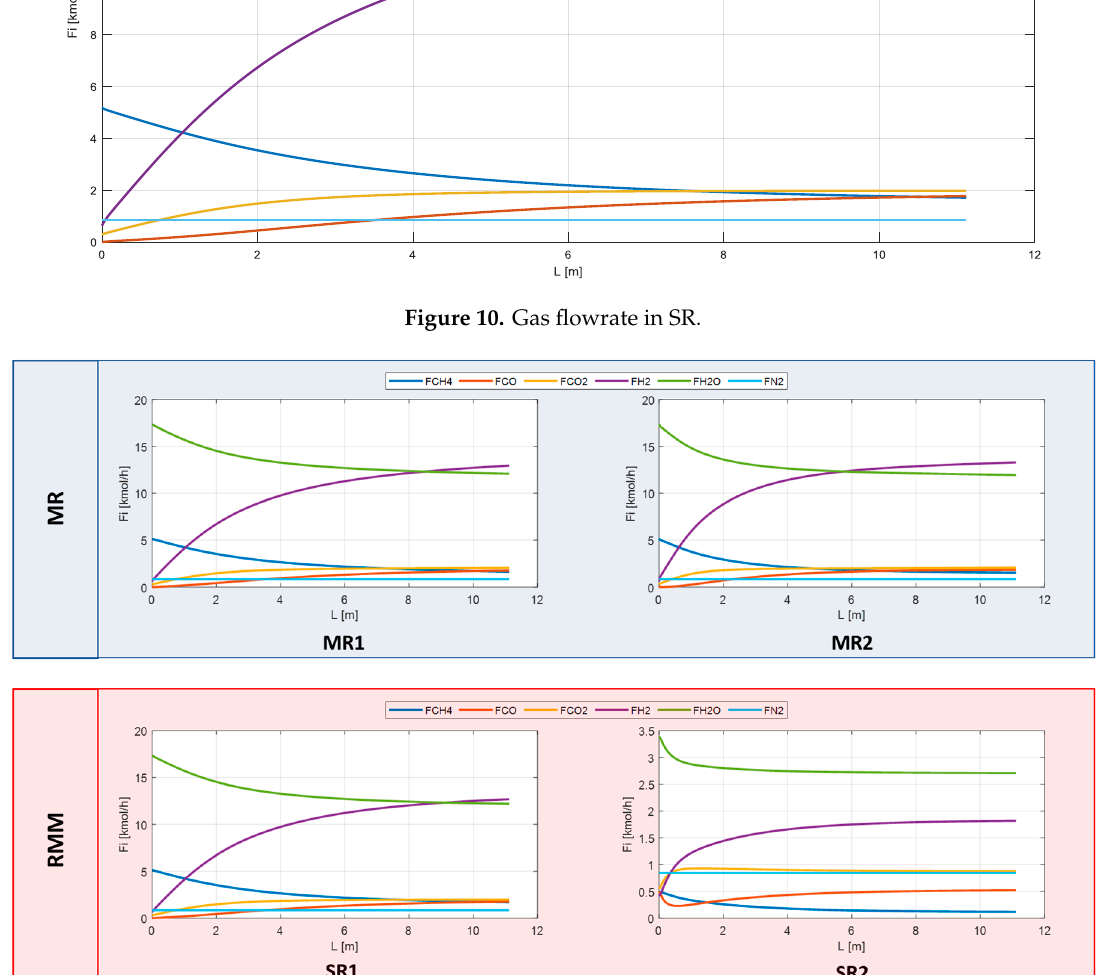
Figure 11. Gas flowrate in MRs and RMM.